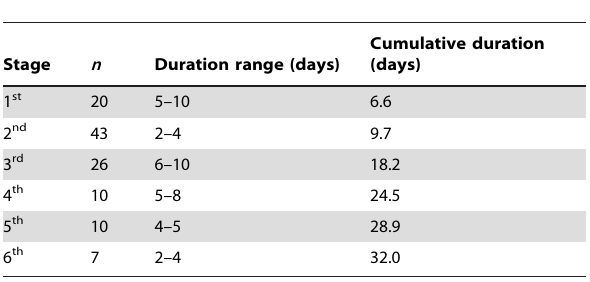
Table 1. Duration of each stage of embryonic development in Iporangaia eggs during the wet and warm season and the corresponding estimated caring period.